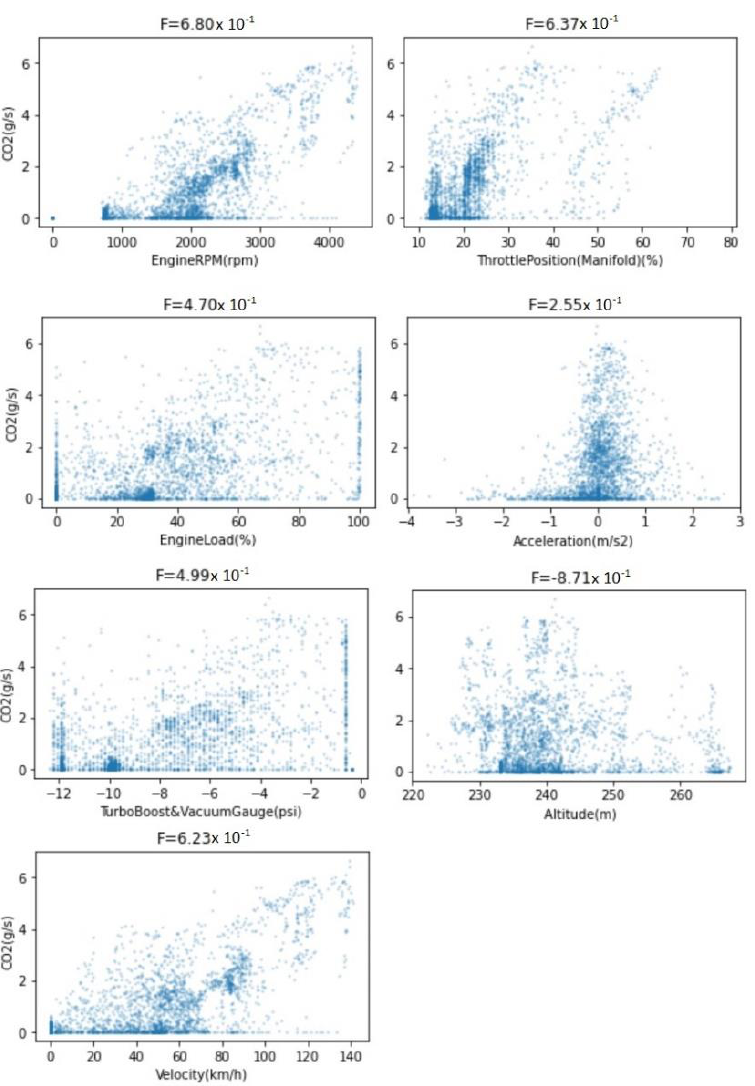
Figure 4. Continuous feature vs. target CO 2 emission; PEMS and OBDII data for LPG vehicle, the higher the value for F, the better the correlation of the test parameter with CO 2 emissions.